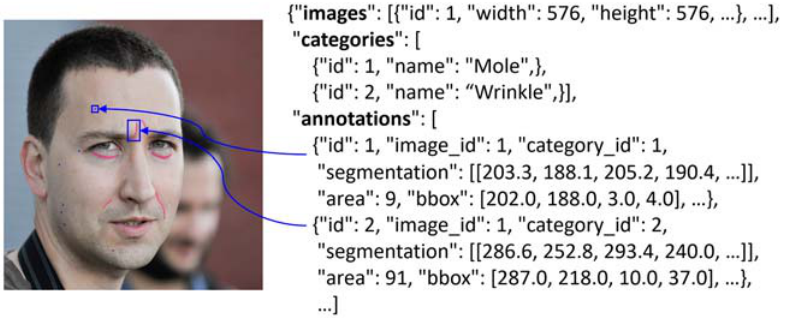
Figure 11. Face photo with annotations and its JSON representation.